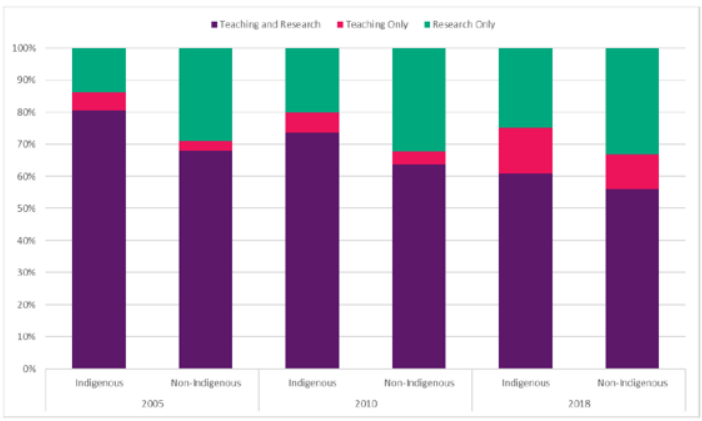
Figure 2: Teaching and research comparison between Indigenous and non-Indigenous staff from 2005 to 2018 (Universities Australia,